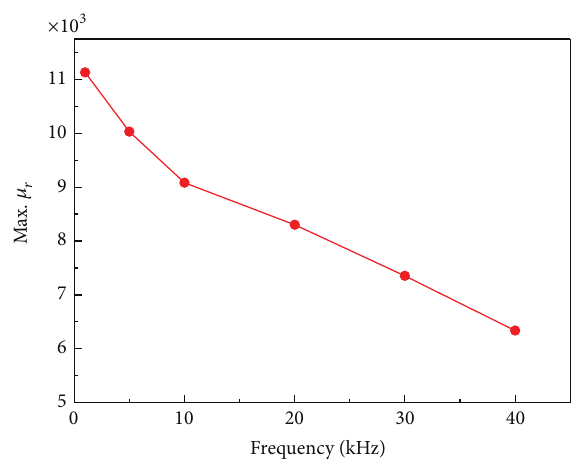
Figure 8: Variation of maximum permeability 𝜇 𝑟 with frequency.